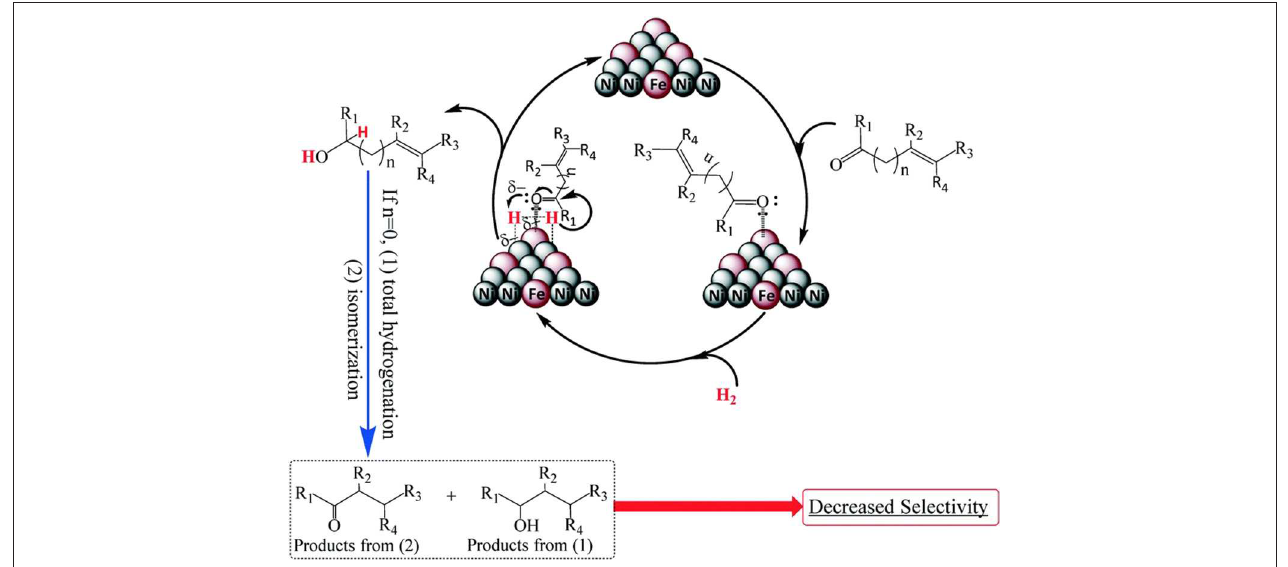
FIGURE 4 | Plausible mechanism for the selective hydrogenation of unsaturated alcohols over Ni–Fe-based alloy. Used with permission of Royal Society of Chemistry, from Putro et al. (2017); permission conveyed through Copyright Clearance Center, Inc.